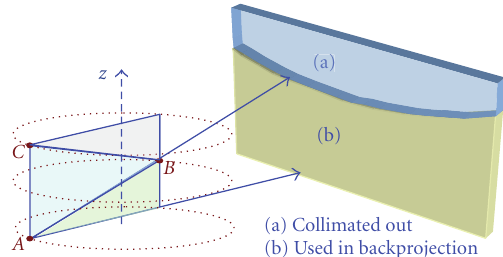
Figure 5: E ffi cient TOM windowing: during the backprojection of each voxel and each view, it is decided if the projection of that voxel falls inside the TOM window and if not, the contribution from that view is discarded. 3 longitudinal sources are marked as A , B , and C .